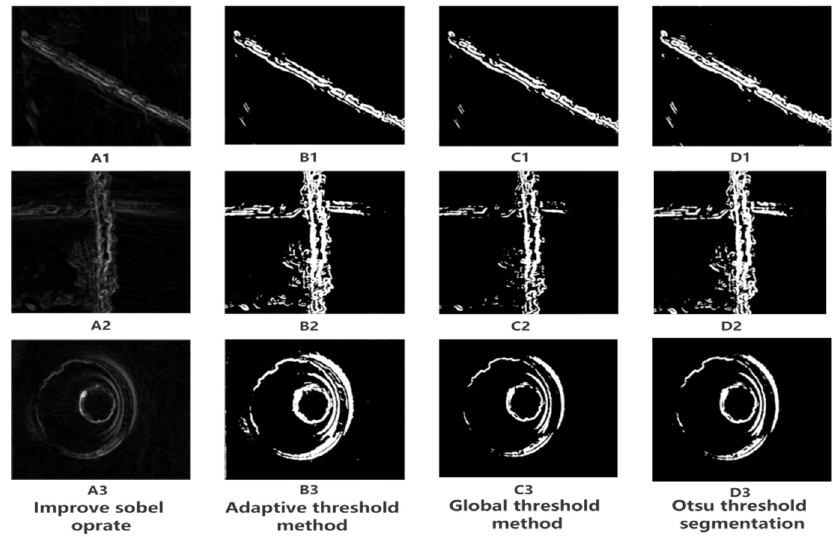
Figure 9. Comparison of pipeline defect image threshold methods.